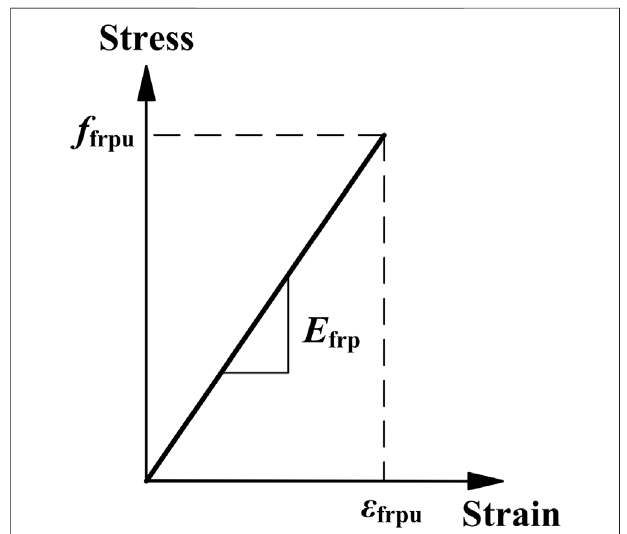
FIGURE 8 | Stress – strain relationship of FRP in the FEM